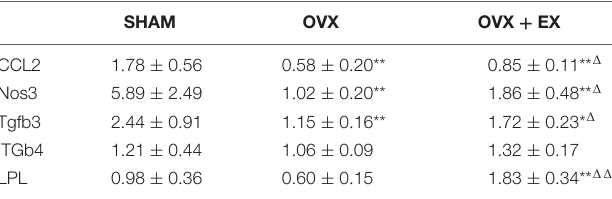
TABLE 5 | The relative expression of Key differential genes